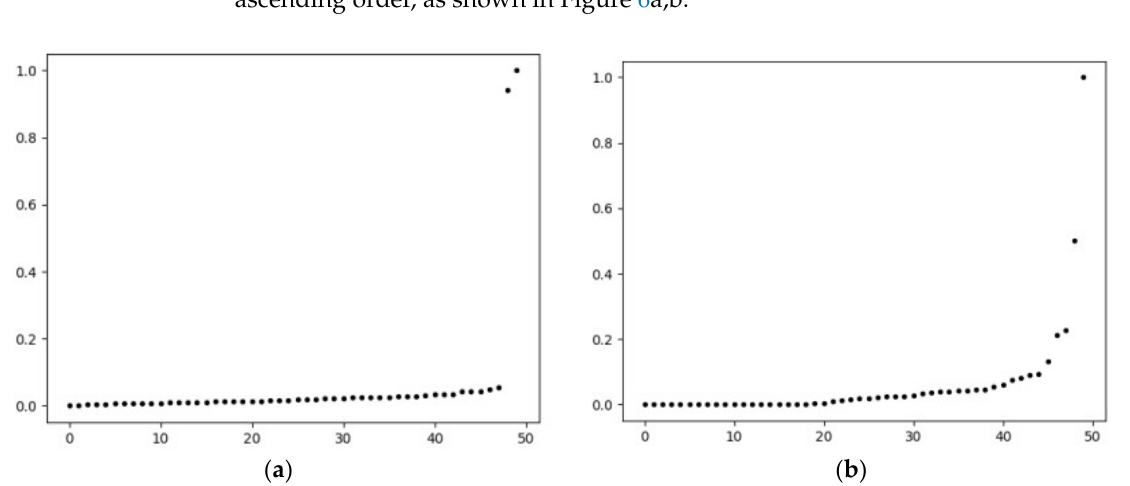
and the clustering effect is very good.